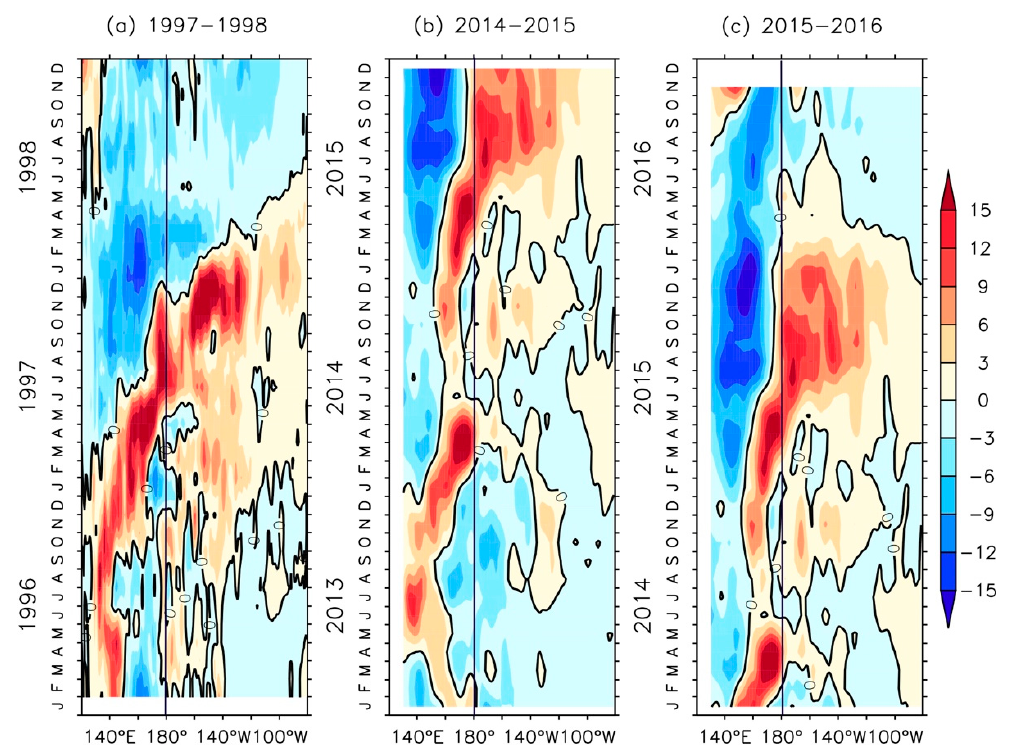
Figure 4. Longitude–time sections of BLT anomaly fields along the equator (averaging over 2° S–2 ° N) during ENs for ( a ) 1997–1998, ( b ) 2014–2015, and ( c ) 2015–2016. The vertical black line represents the location of the international the dateline. The units for BLT are m.